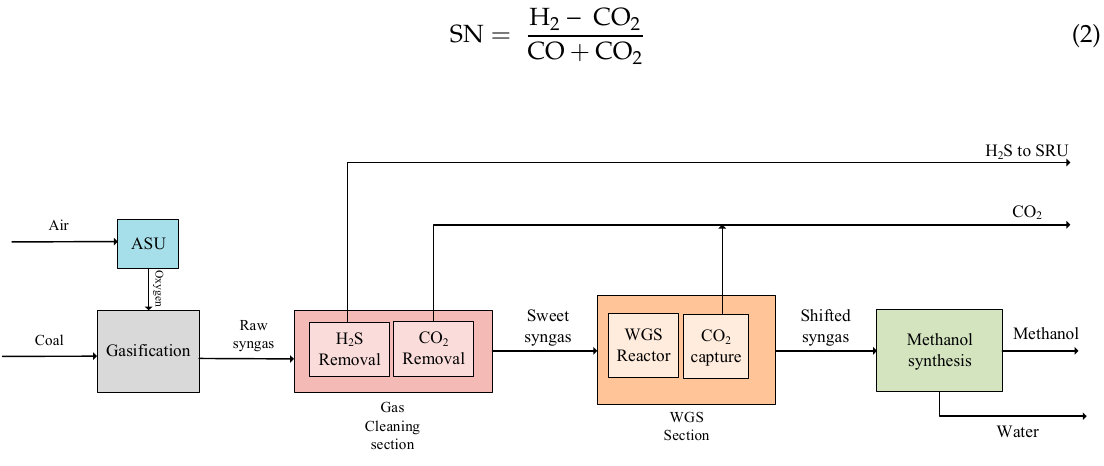
Figure 2. Block flow diagram for the base case CTM process.